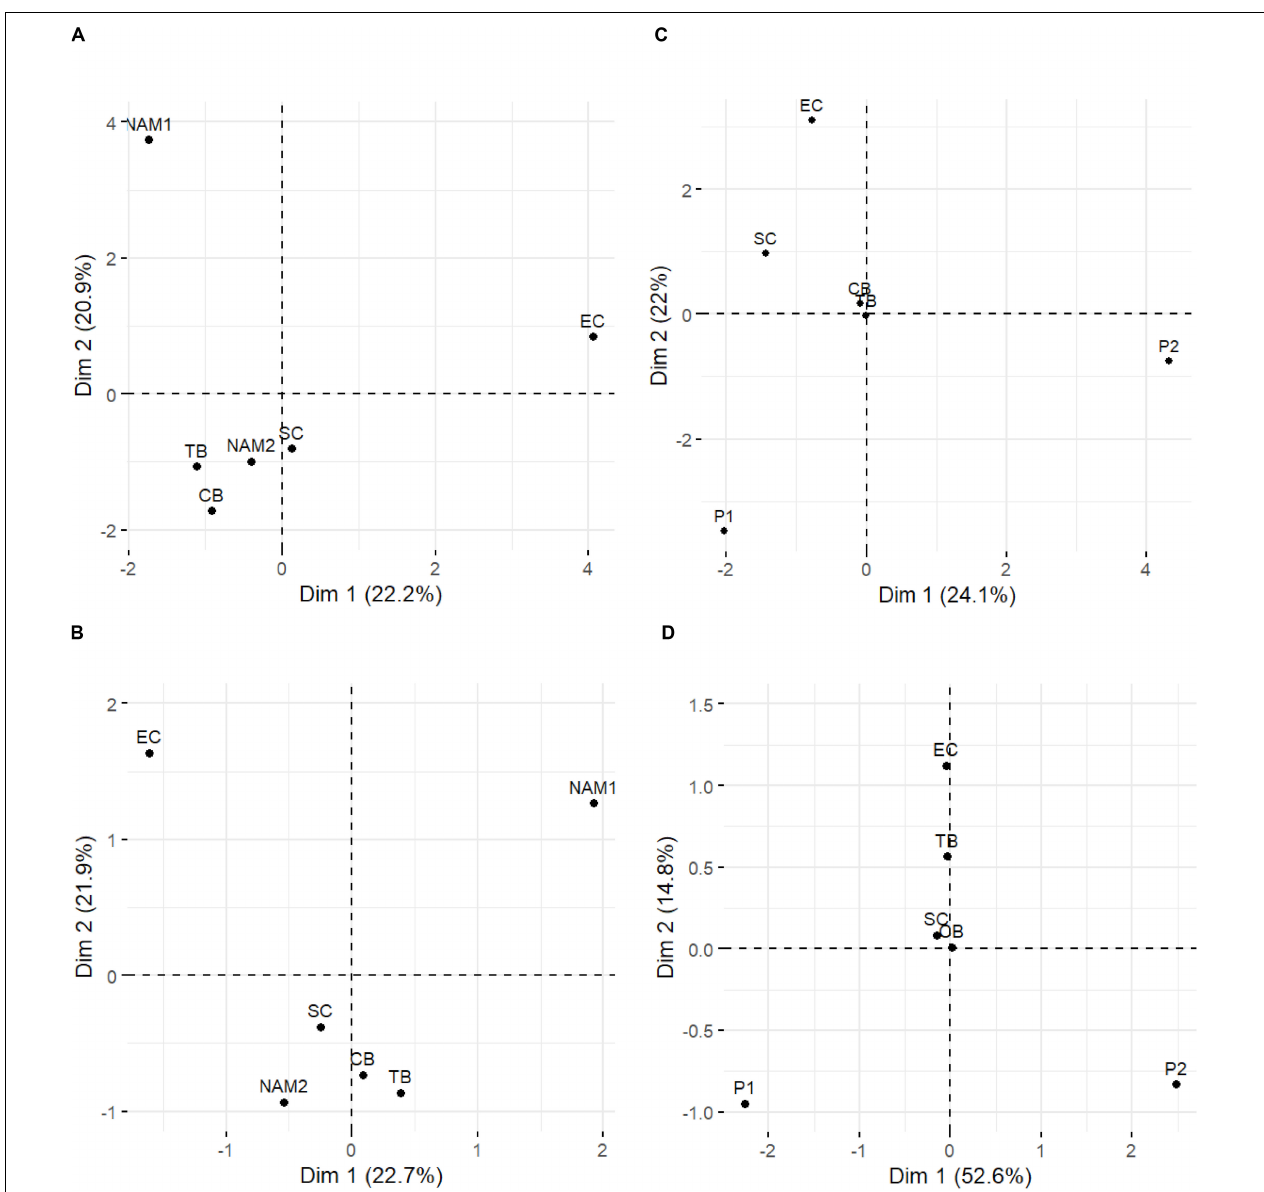
FIGURE 2 | Principal component analysis (PCA) of variation in allele frequencies per pool, based on full (neutral and outlier loci – A ) and outlier loci (B) for the 2017 samples, as well as full (C) , and top 500 loci (D) for the South African comparisons. Pool names as per Table 1 .